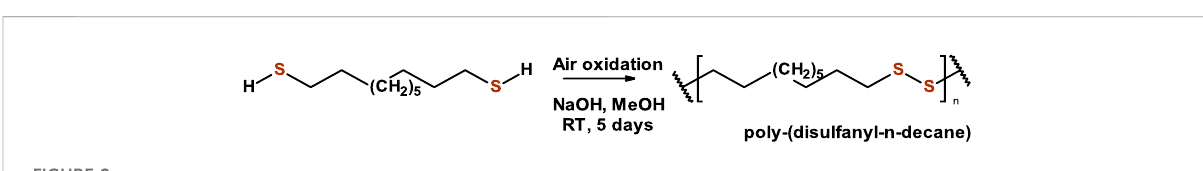
FIGURE 1 Synthesis of poly-VI-VIM copolymer, n/m = 3.75.